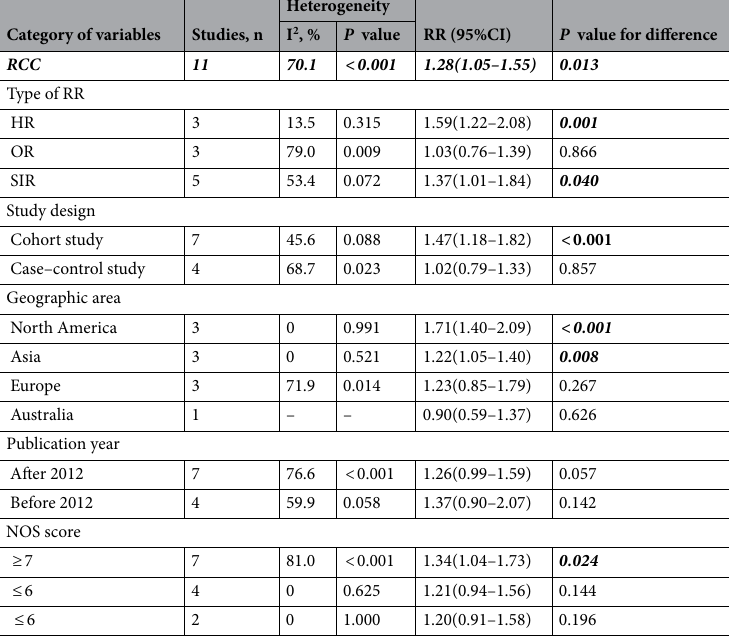
Table 2. Subgroup analysis of association between HCV and RCC risk. HCV = hepatitis C; RCC = renal cell carcinoma; BC = bladder cancer; PCa = prostate cancer; RR = relative risk; HR = hazard ratio; OR = odds ratio; SIR = standardized incidence ratio; NOS = Newcastle–Ottawa Scale;